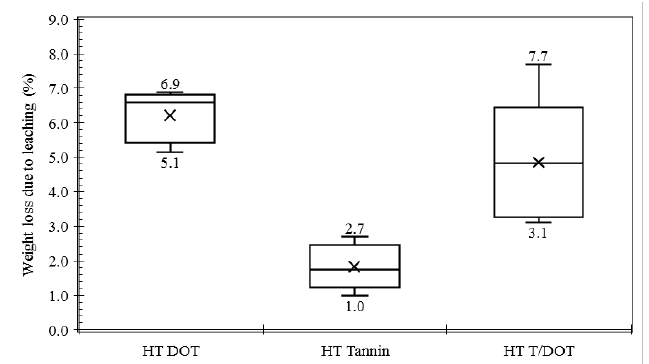
Figure 5. Weight loss due to leaching in termite samples. (x = mean; horizontal line = median, whisker = range).